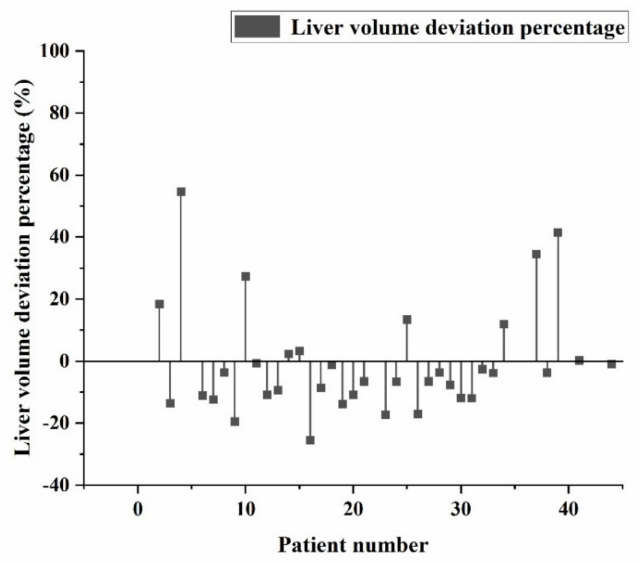
Figure 11. Percentage error between pathological data and identified data for individual patients after adding hospital data training.